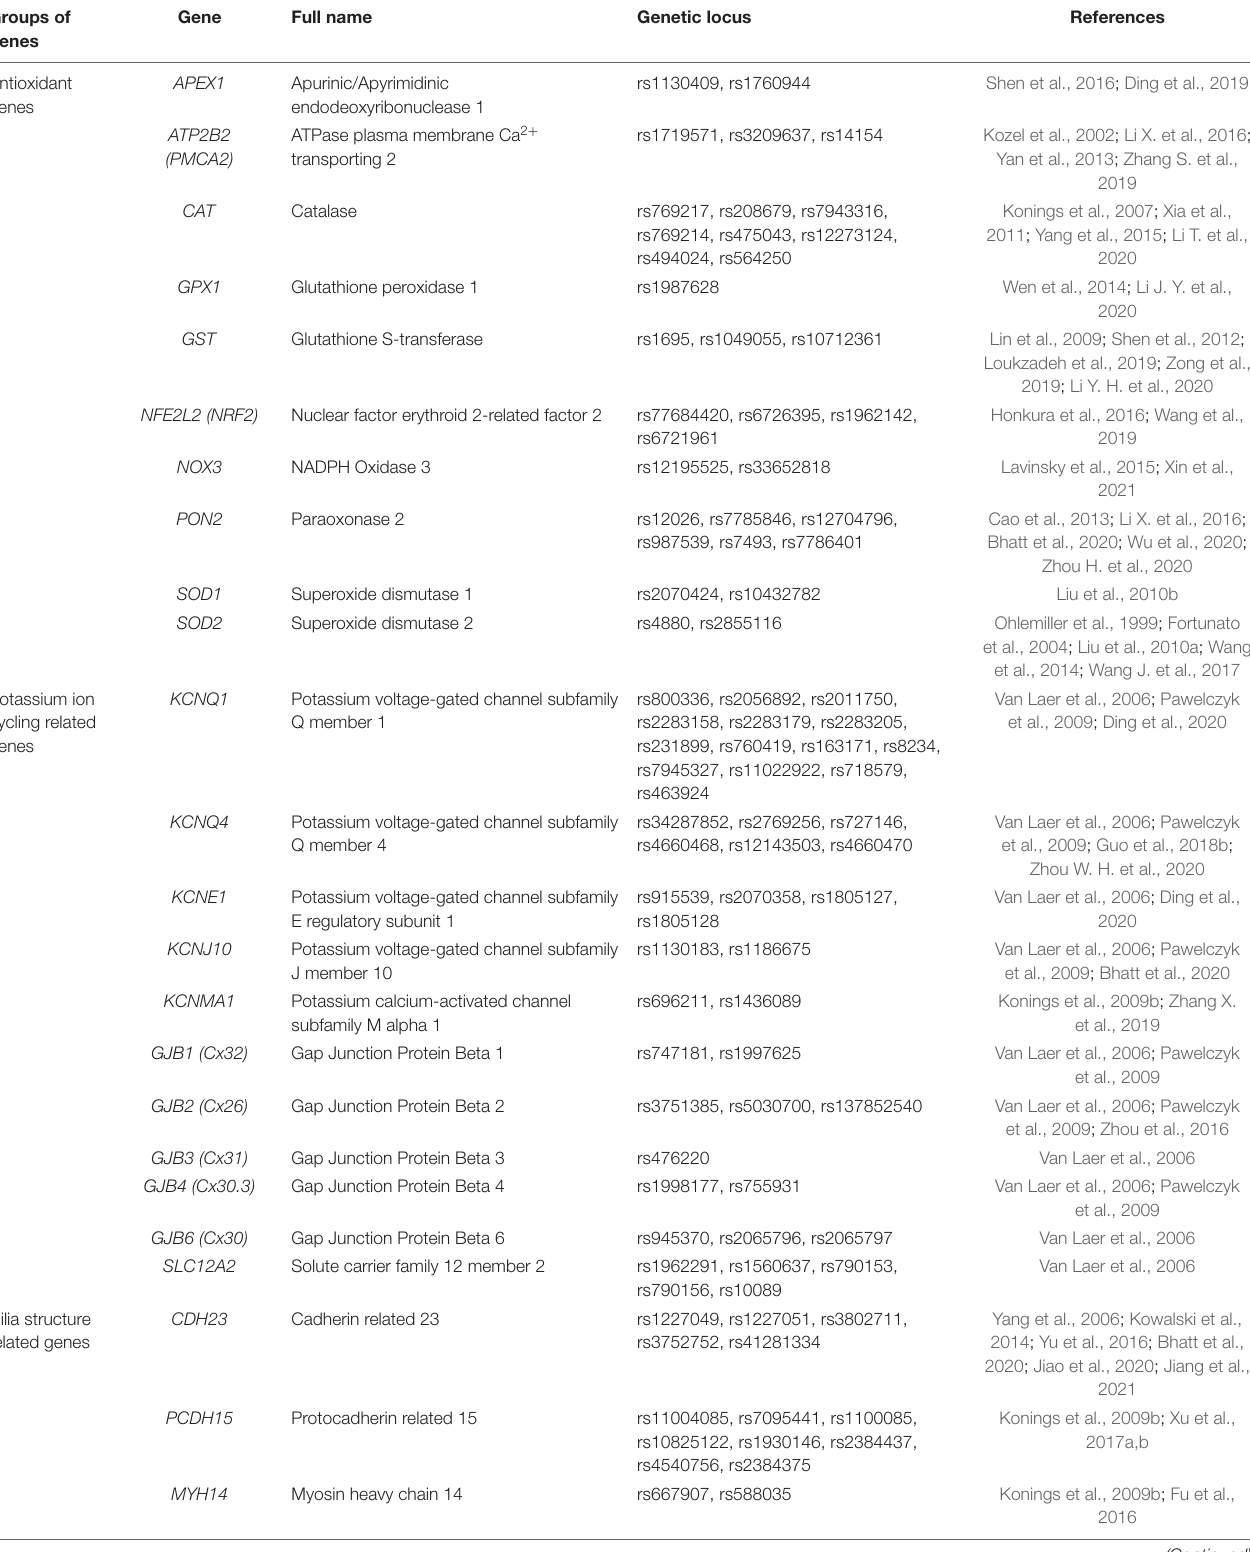
TABLE 1 | Summary of NIHL susceptible genes and their